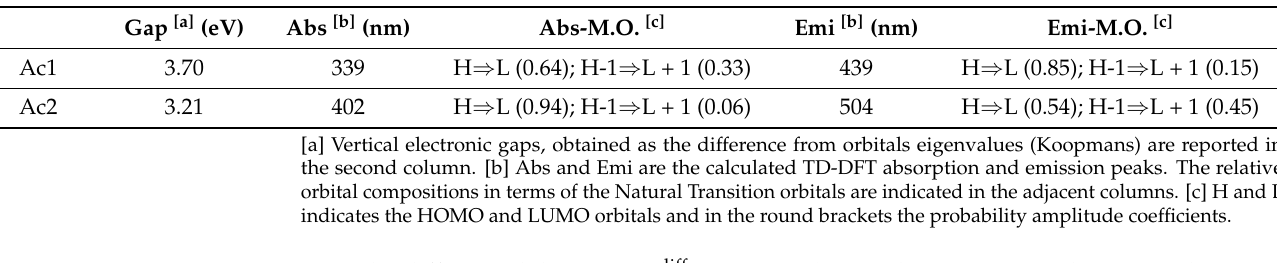
Table 2. Electronic excitation analysis for Ac1 and